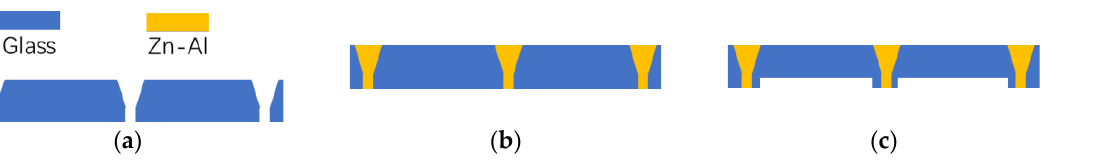
Figure 5. Preparation of the TGV cover: ( a ) laser drilling; ( b ) metal filling and CMP; ( c ) active area corrosion.